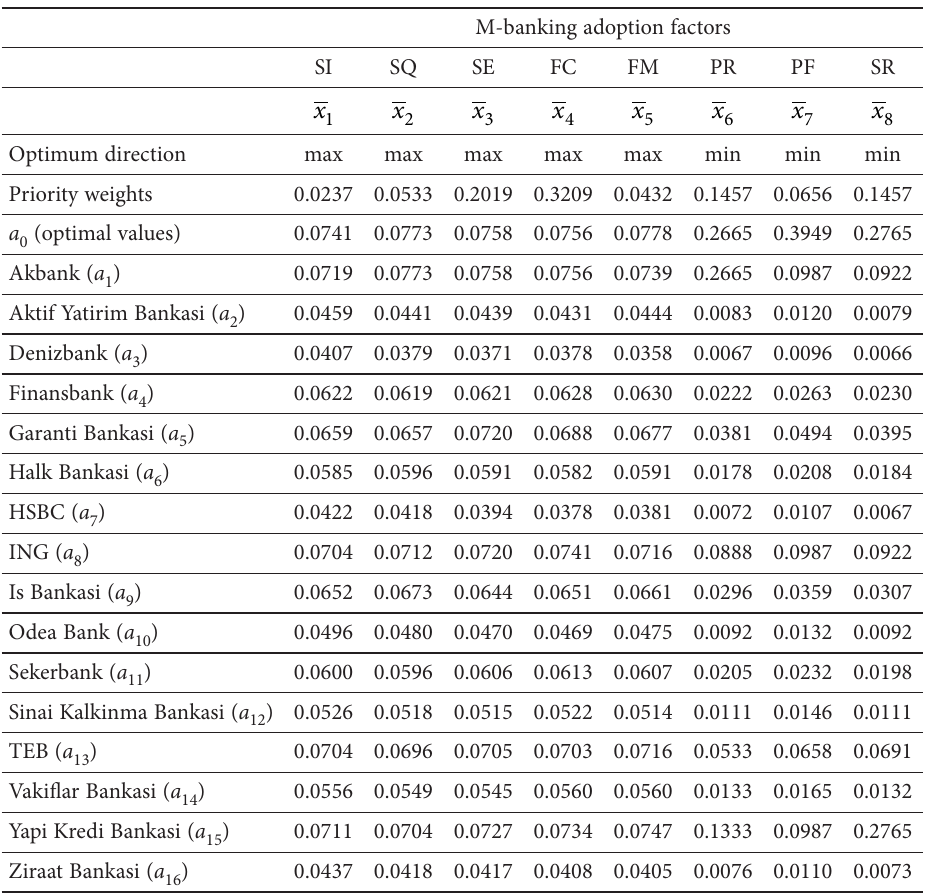
Table 12. Normalised decision making